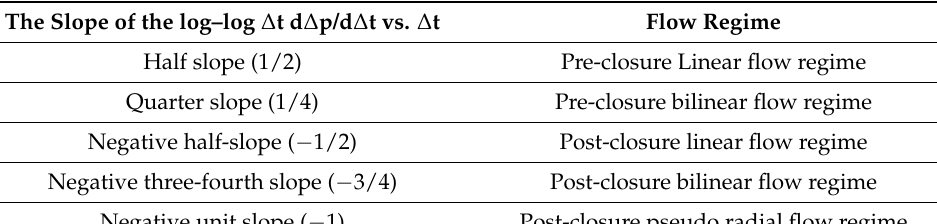
Table 1. The flow regimes that happen pre-closure and post-closure and their corresponding slopes on the log–log ∆ t d ∆ p /d ∆ t versus ∆ t. The Slope of the log–log ∆ t d ∆ p/d ∆ t vs. ∆ t